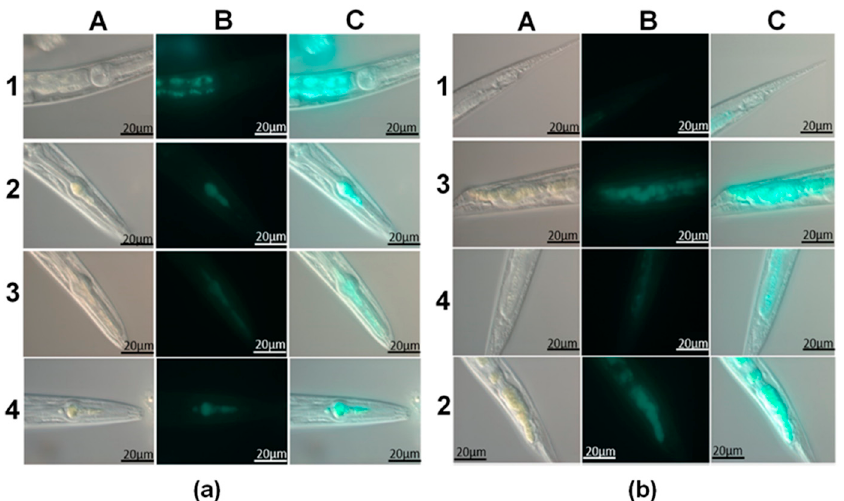
Figure 4. ( a ) Images of the throat of the nematodes fed with fluorescent halloysite nanotubes; ( b ) Tails of the nematodes fed with fluorescent halloysite nanotube. A—optical images, B—fluorescence image, C—alignment of optical and fluorescence images, 1—pristine halloysite, 2—CdS/HNT-Azine, 1—Cd 0.7 Zn 0.3 S/HNT-Azine, 3—CdS/HNT-NH 2 .